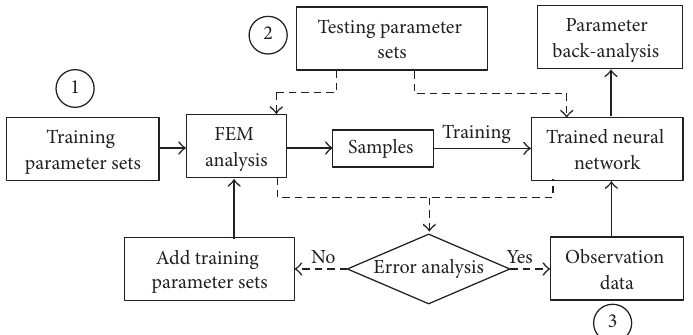
Figure 3: Displacement back-analysis method based on neural network and evolutionary algorithm.